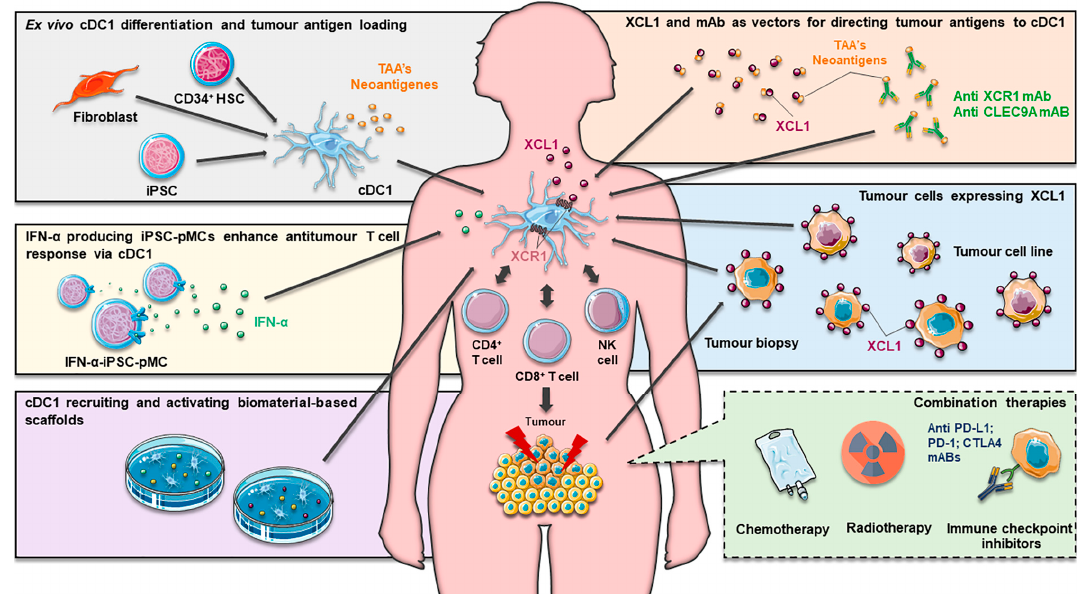
Figure 3. Summary of current approaches exploring cDC1 in immunotherapy. To overcome the scarcity of natural circulating XCR1 + DCs, which hampers their clinical application, new protocols have